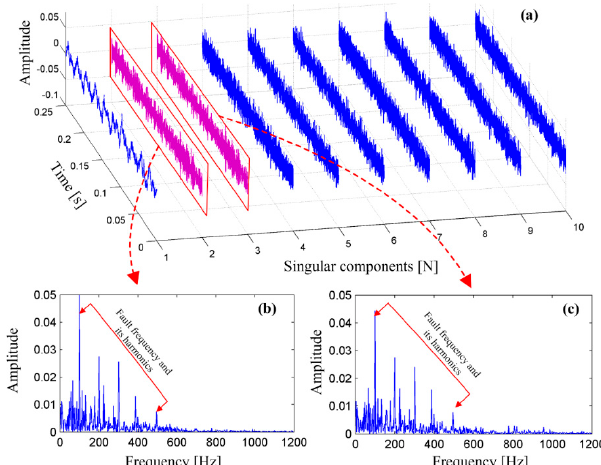
Figure 9. The singular components, ( a ) their Teager energy operator spectrum; ( b ) The second spectrum; and ( c ) The third spectrum.